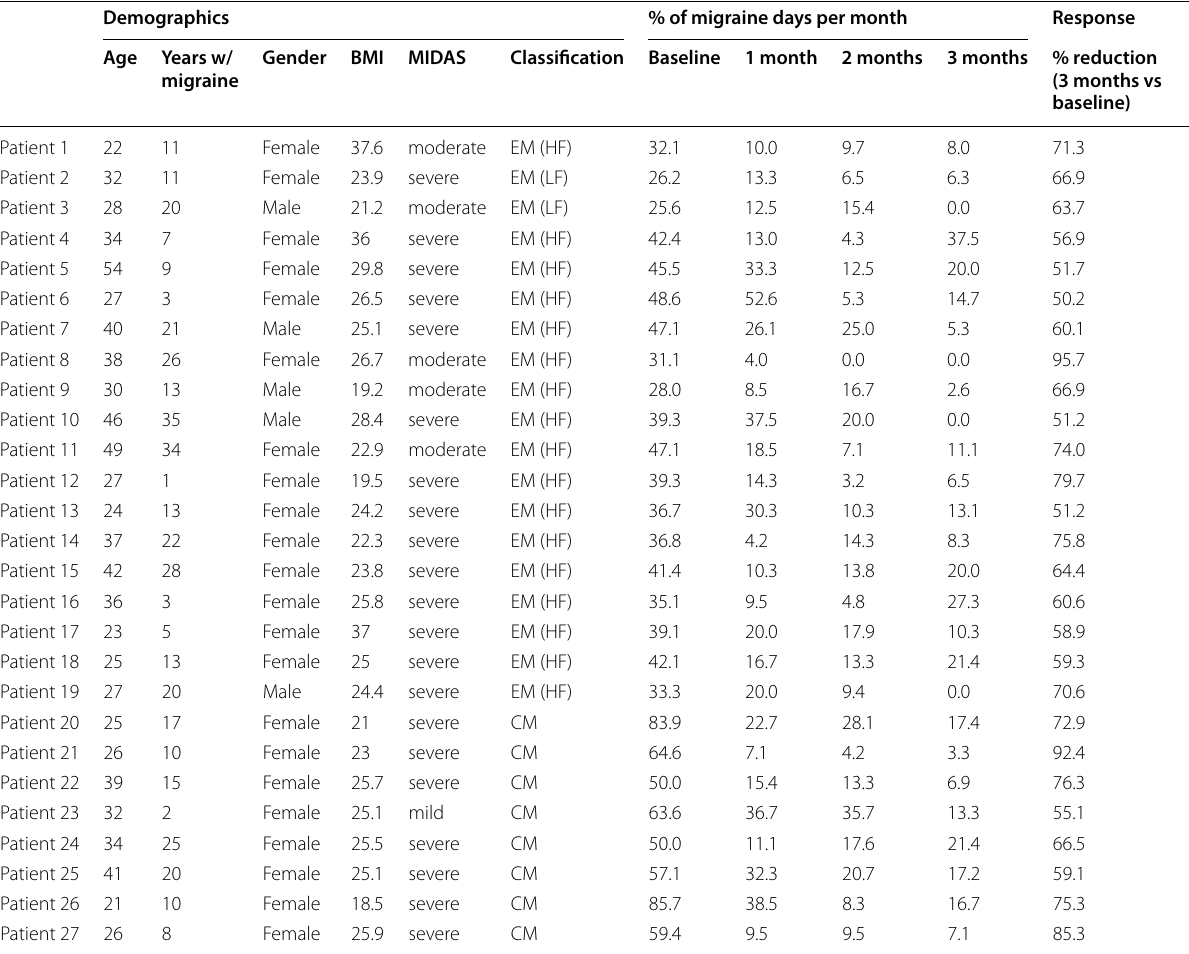
Table 1 Responders demographics, classification and reduction in migraine days per month Demographics % of migraine days per month